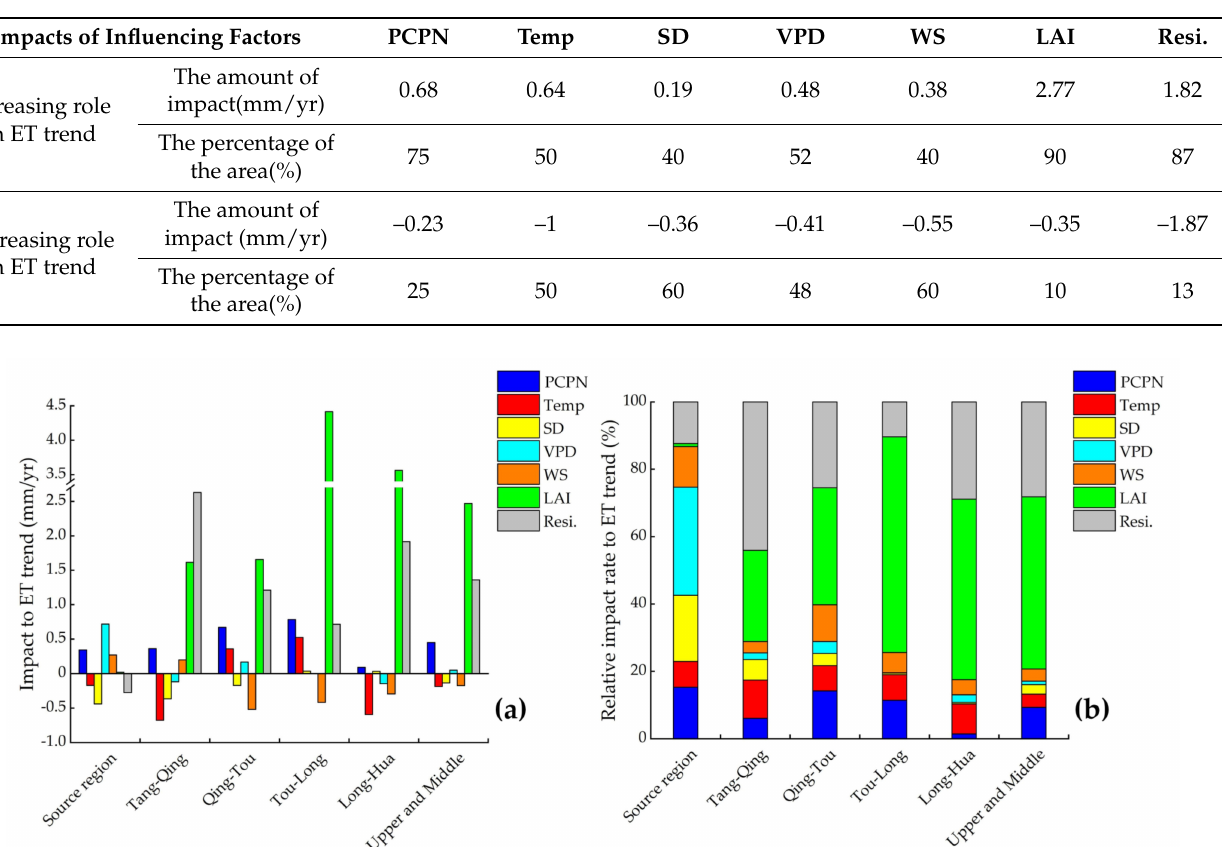
Table 3. The impact quantities and area percentages of increasing and decreasing roles of different influencing factors on the ET trend over the whole YRB.